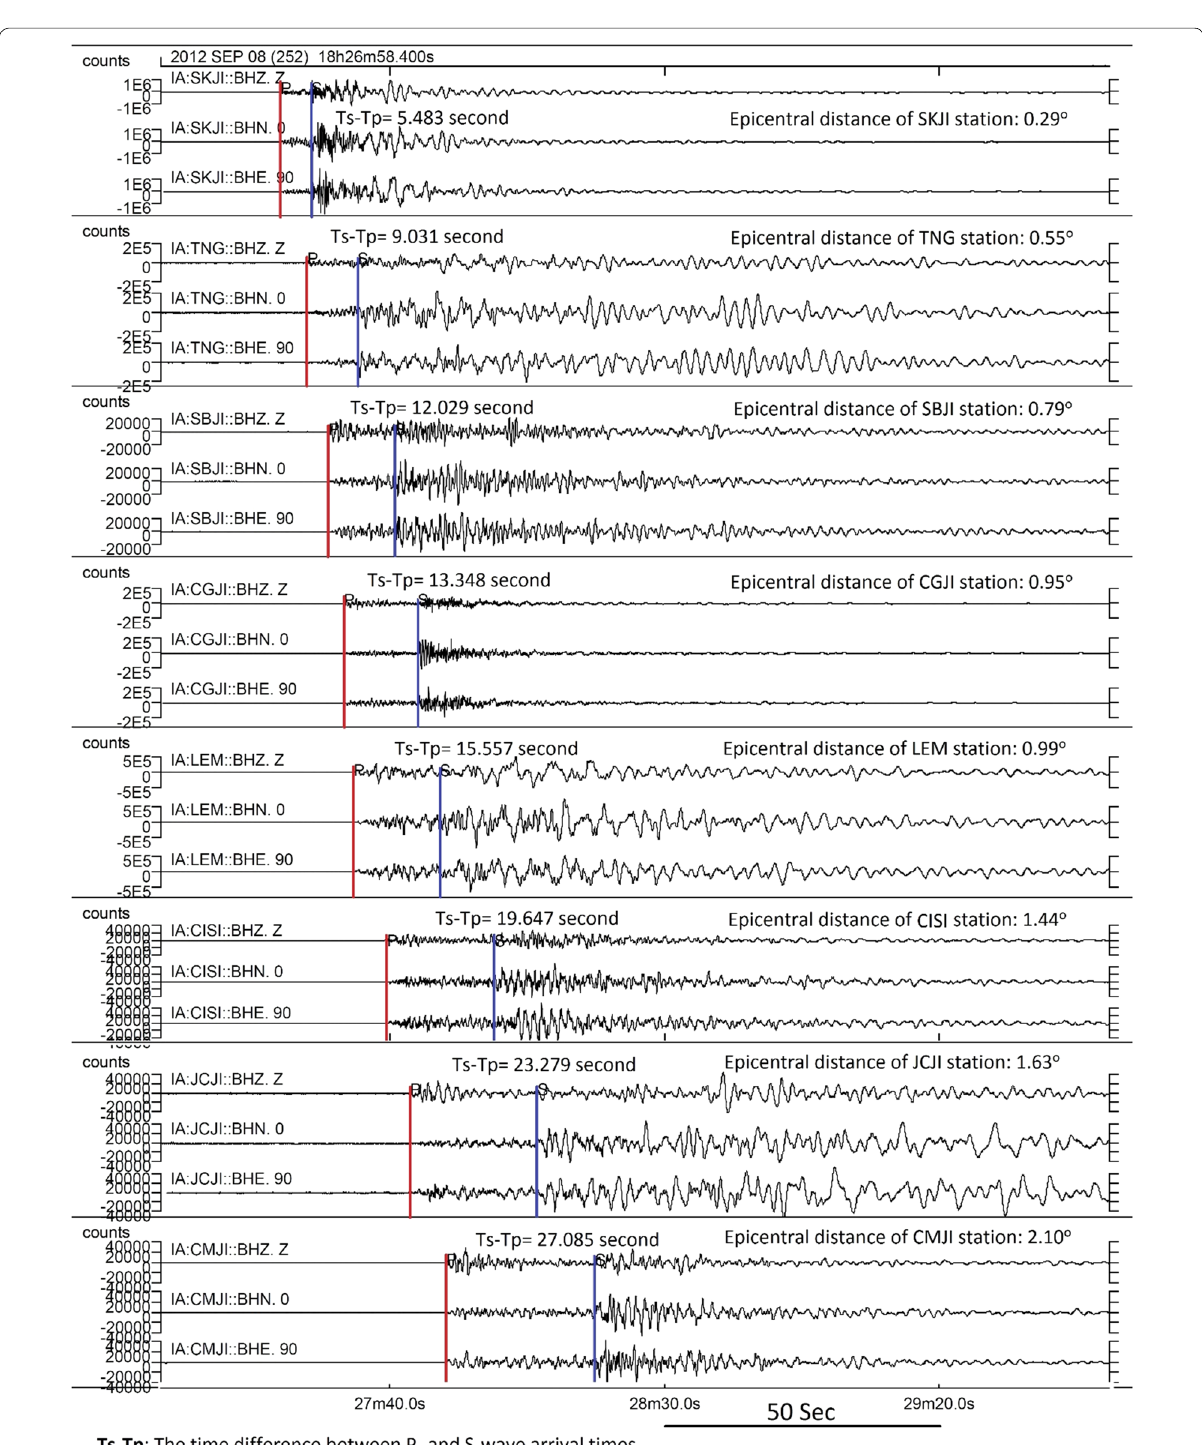
Fig. 1 Three-component seismogram examples of 8 September 2012 event. From top to bottom, seismograms recorded at stations SKJI, TNG, SBJI, CGJI, LEM, CISI, JCJI, and CMJI (the location of epicenter is shown in Fig. 5). Red and blue lines indicate the picks of P- and S-wave arrival times,